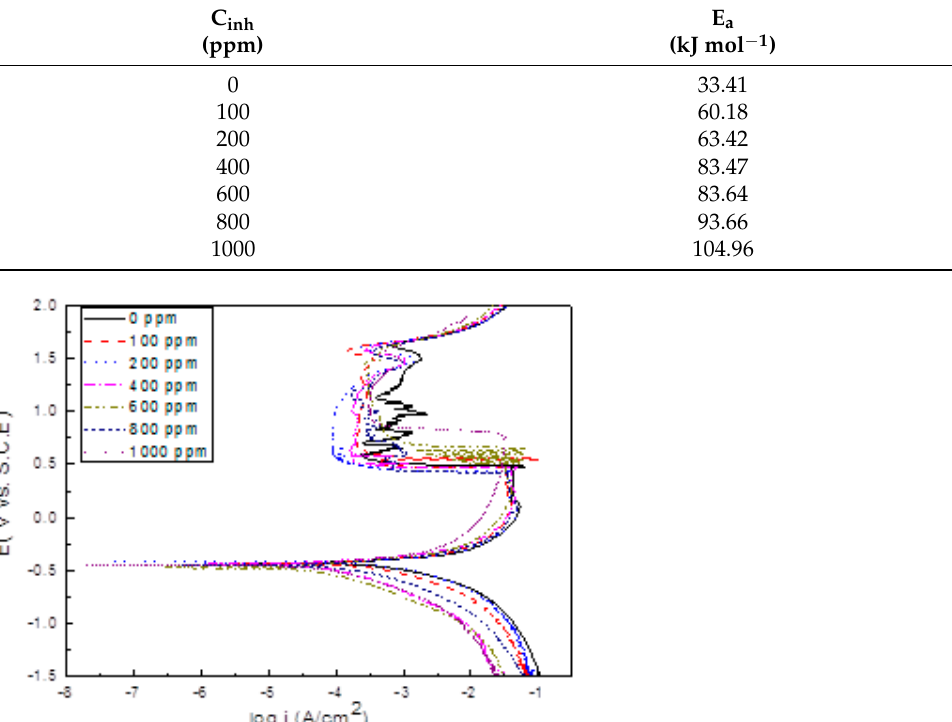
Figure 5. Effect of α -linolenic acid concentration in the polarization curves for 1018 carbon steel in 0.5 M H 2 SO 4 . Table 2. Electrochemical parameters obtained from polarization curves.